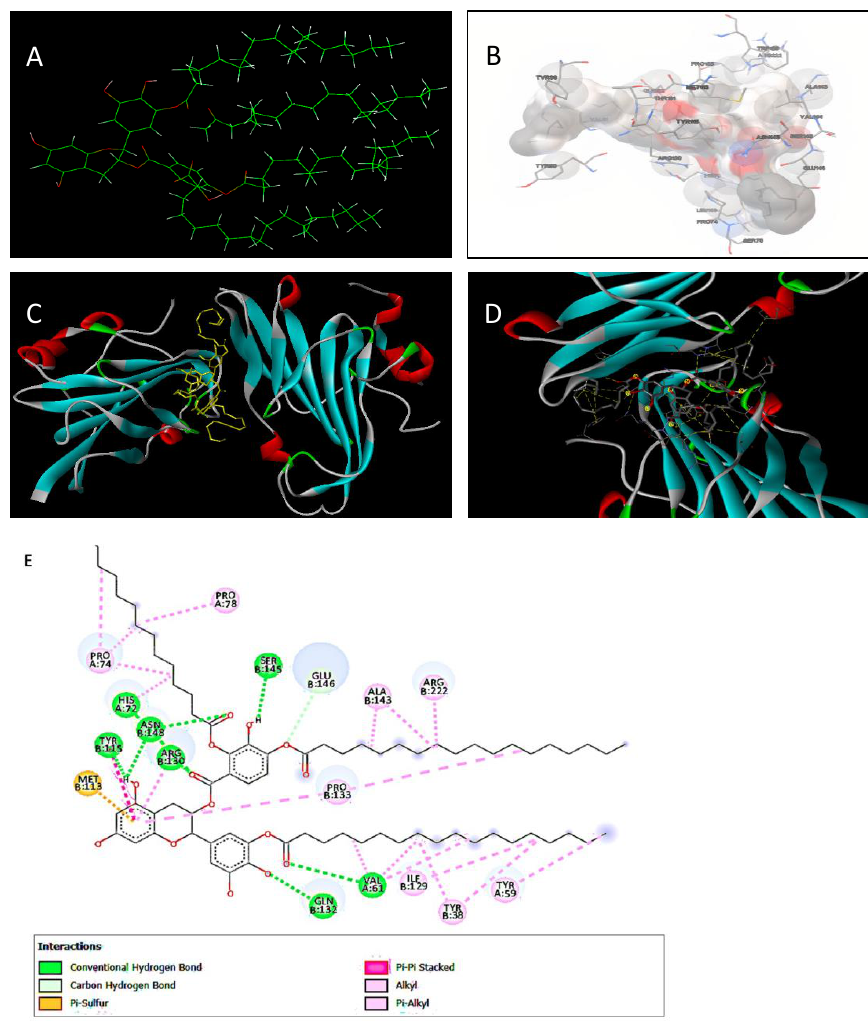
Figure 8. Bioinformatic analysis of the interaction of HSV-2 glycoprotein D (gD) and EGCG-S. ( A ) 3D Structure of EGCG-S in VegaZZ; ( B ) Predicted binding interaction between EGCG-S and glycoprotein D based on AutoDock Vina analysis; ( C ) Ribbon model of binding between glycoprotein D and EGCG-S; ( D ) Enhanced ribbon image of binding between glycoprotein D and EGCG-S; ( E ) Two- dimensional diagram of receptor-ligand interactions including conventional hydrogen bonds (green), van der Waals (light green), pi-sulfur (yellow), pi–pi stacked (dark pink), alkyl and pi-alkyl (pink).